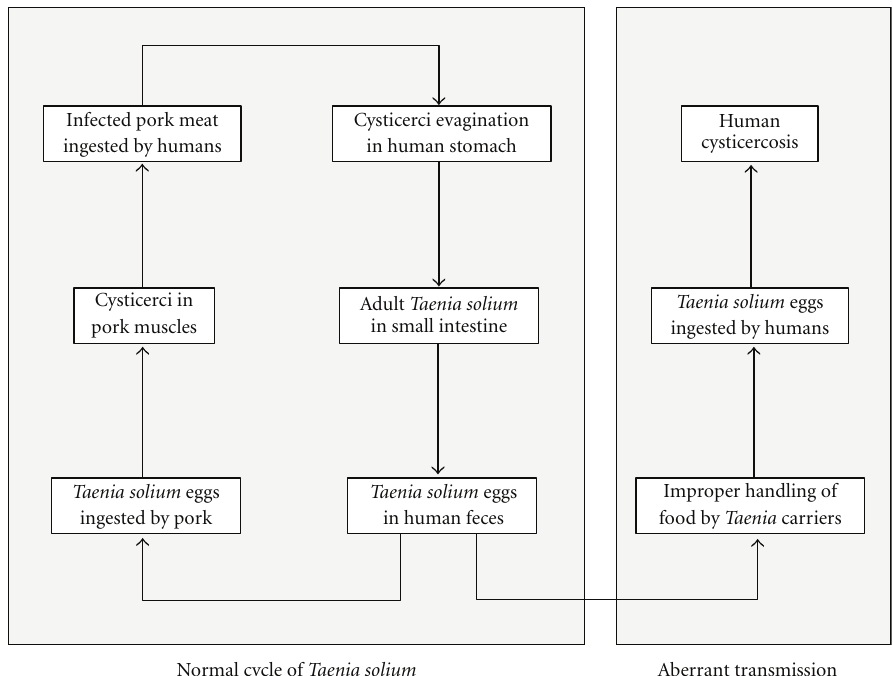
Figure 2: Life cycle of Taenia solium showing the normal cycle of transmission, when humans act as definitive hosts and pigs as intermediate hosts, and the aberrant cycle of transmission, when humans become intermediate hosts, developing cysticercosis.